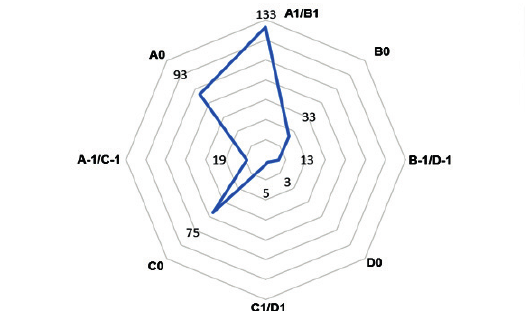
Figure 2. The frequency count of visitors emotions in circumplex model of core affect (source: created by